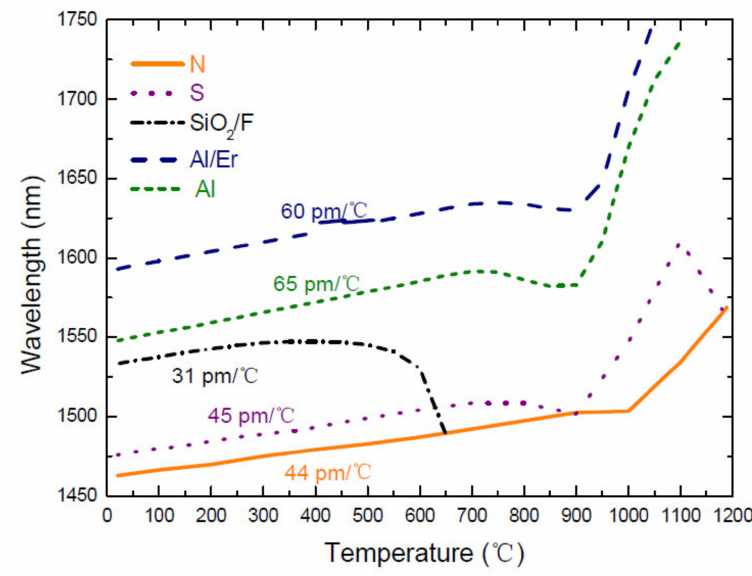
Figure 3. Thermal behavior of LPFGs arc-induced in Ge-free fibers. Reprinted from [86].